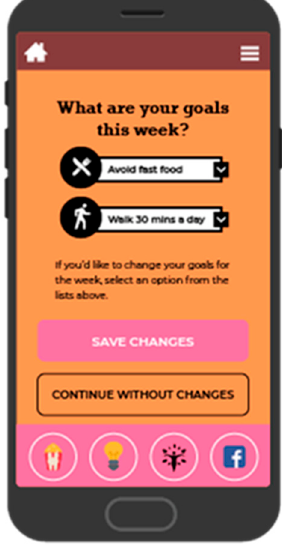
Figure 3. Screenshot of goal setting.